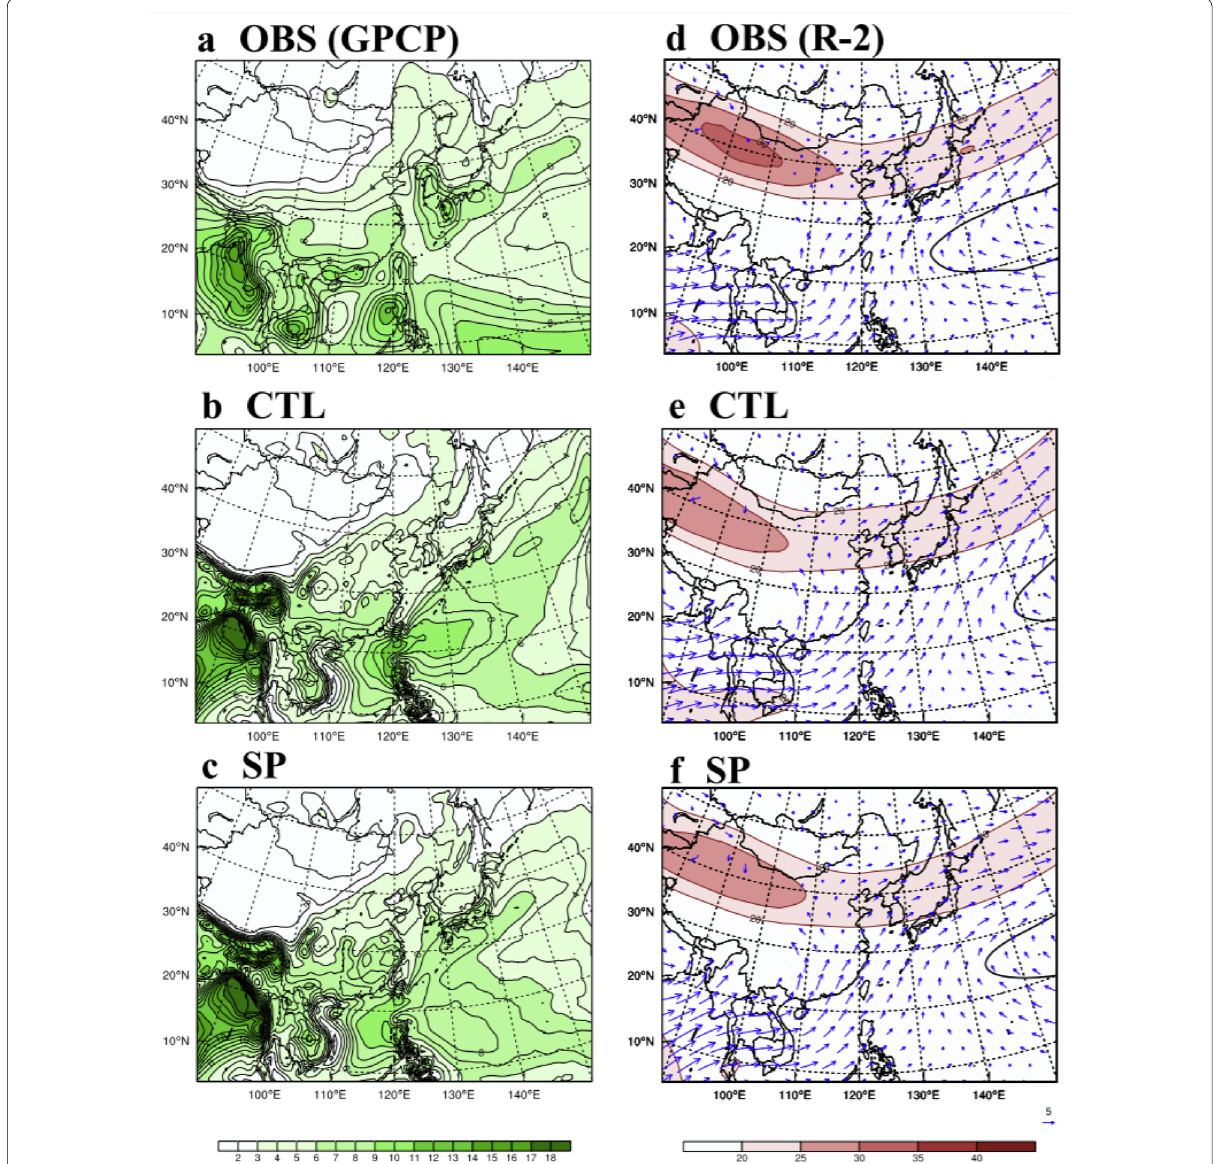
Fig. 1 a – c 28‑year (1979–2006) climatology of seasonal mean precipitation (mm day − 1 ) and d – f 28‑year climatology of seasonal mean 850 hPa wind vector, 200 hPa wind speed (m s − 1 , contour and shading), and 5880 geopotential height contours (solid lines). Upper, mid, and bottom panels indicate observation, control experiment (no nudging), and spectral nudging experiments, respectively (adapted from Cha and Lee